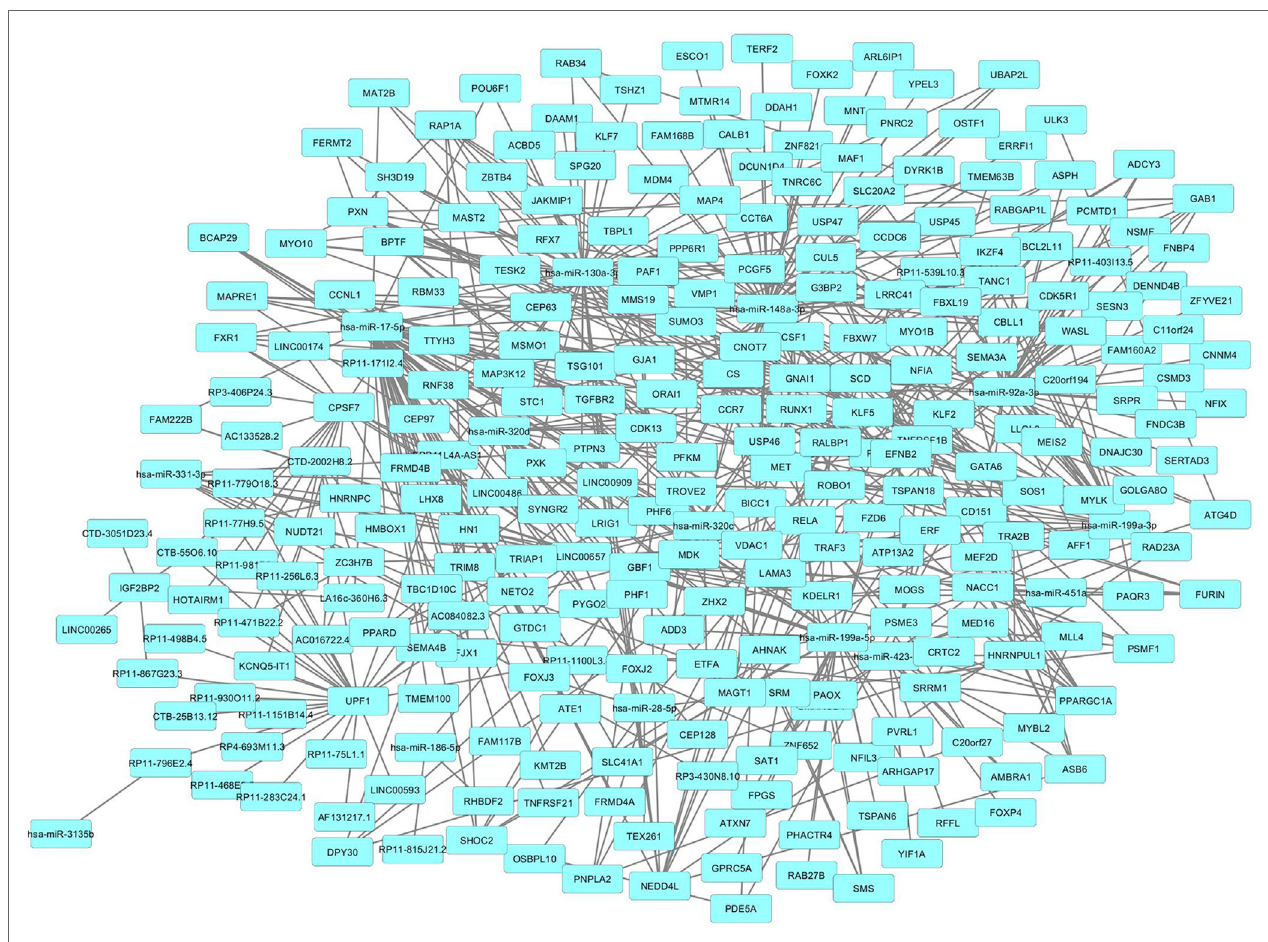
FigUre 2 | Protein–protein interaction (PPI)-network of differently expressed genes in psoriatic arthritis (PsA) targeted by the selected long non-coding RNAs and microRNAs modulated in